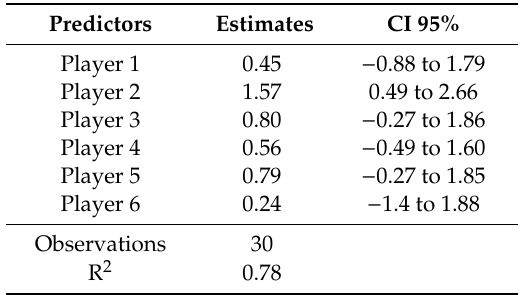
Table 3. Multi-level model depending on ELO di ff erences between rivals and round played. Predictors